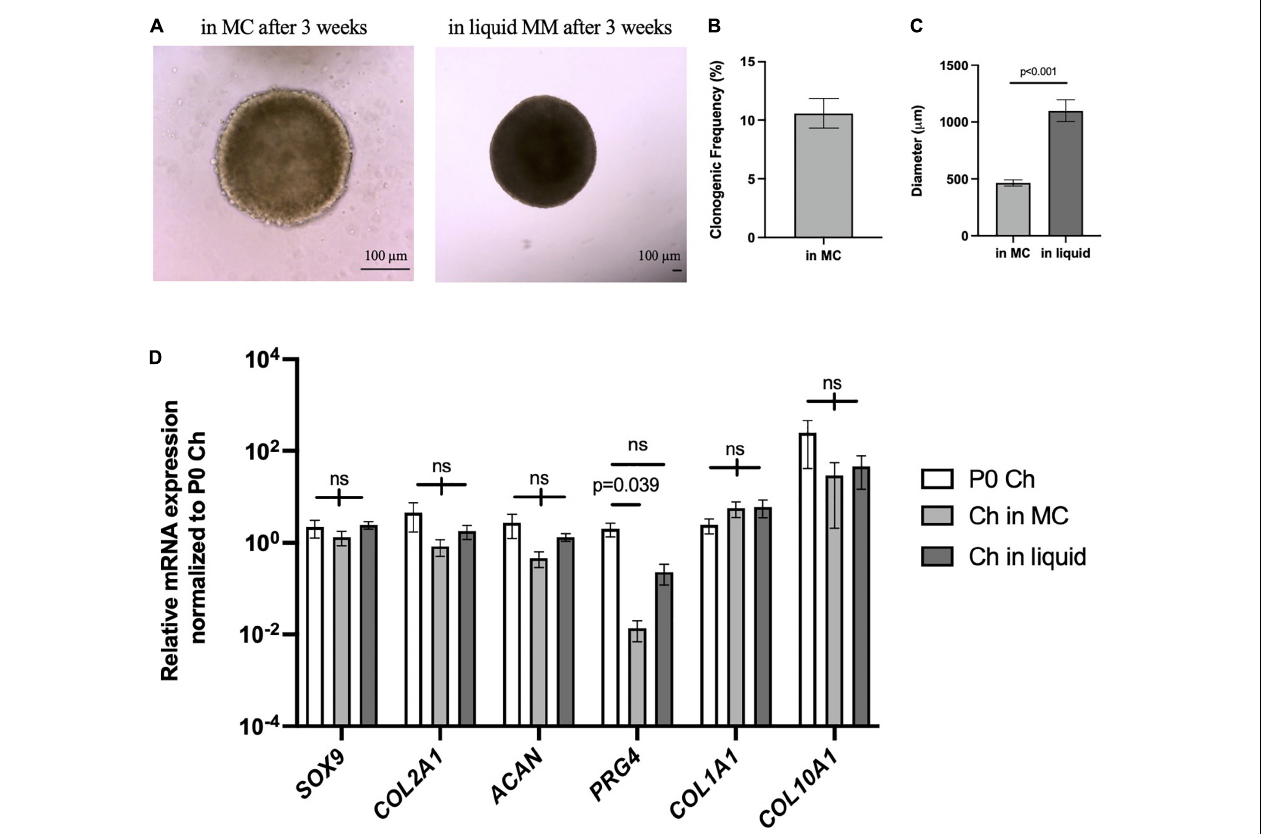
FIGURE 7 | Porcine articular chondrocytes proliferate and maintain chondrogenic identity in 3D culture. (A) Representative images of pig chondrospheres in MC after 3 weeks (left) and after transition into liquid media for an additional 3 weeks (right); scale bar = 100 µ m. (B) Clonogenic frequency of chondrospheres in MC, n = 9 biological replicates. (C) Average diameter of chondrospheres in MC versus liquid; n = 9 biological replicates, p -value calculated using an unpaired t -test. (D) qPCR of chondrogenic genes after normalizing expression to freshly isolated P0 chondrocytes; n = 9 biological replicates and p -value calculated by two-way ANOVA with Tukey’s correction for multiple comparisons. All data represented as mean ±